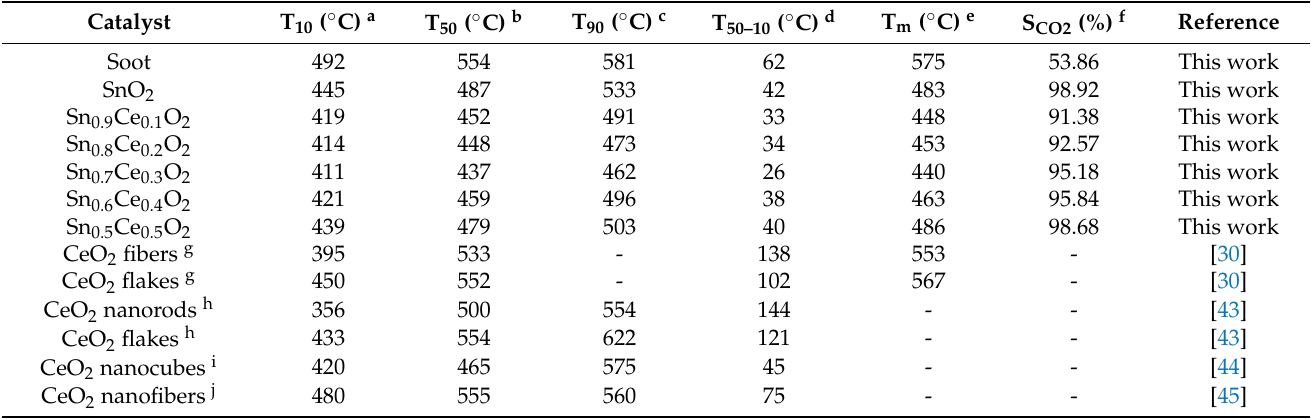
Table 3. Soot combustion activity of the SnO 2 and Sn x Ce 1 − x O 2 fiber catalysts.